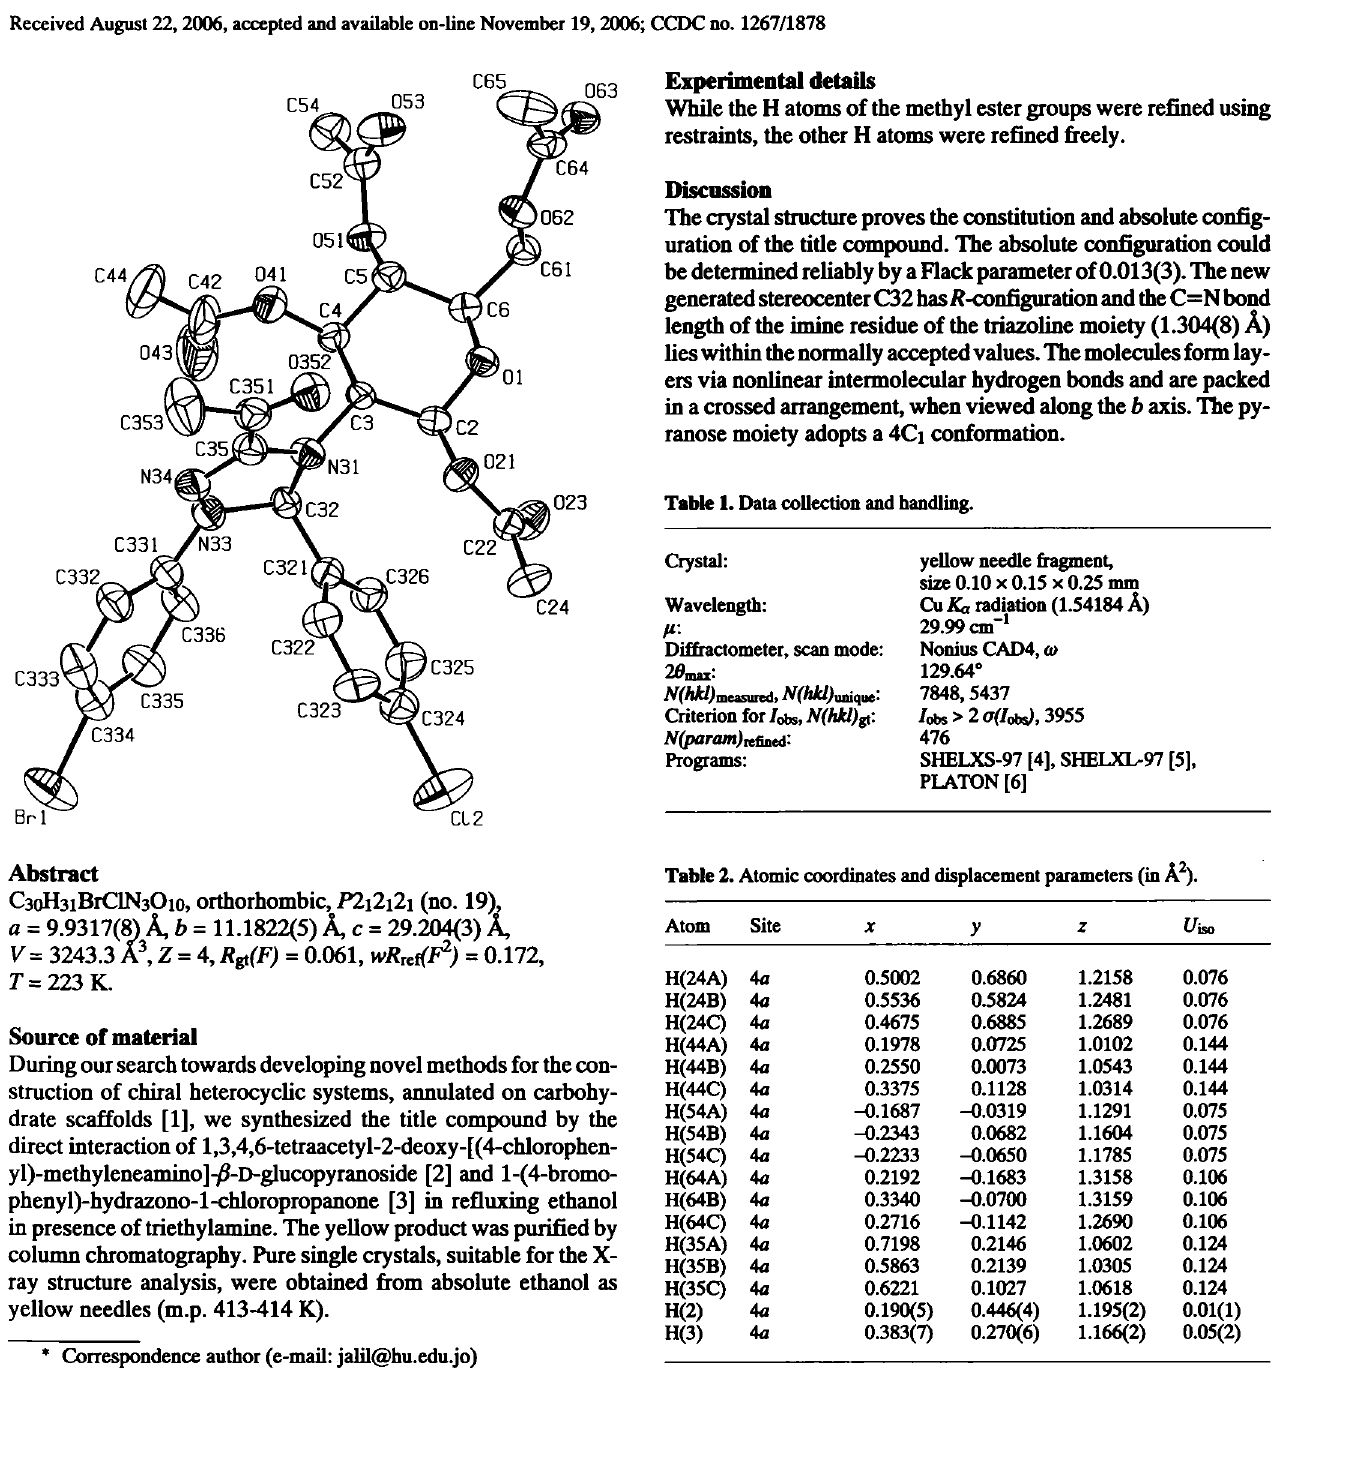
Table 1. Data collection and handling.